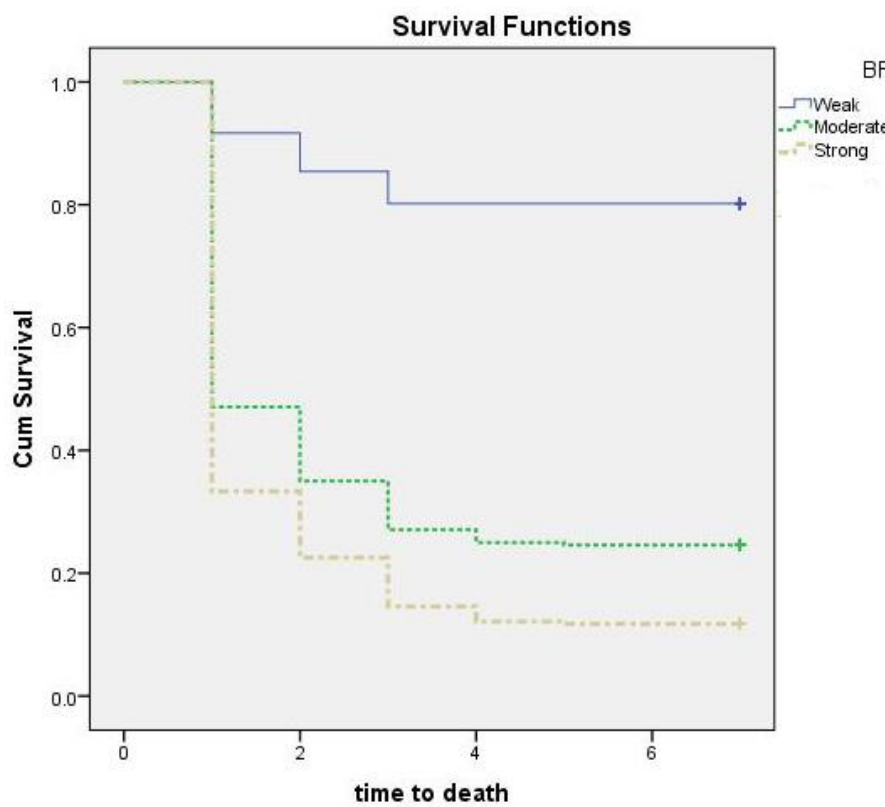
Figure 2. Pairwise comparison for the survival of G. mellonella larvae infected with clinical carbapenem-resistant Acinetobacter baumannii (CRAB); BF, biofilm. Isolates divided into three groups according to its biofilm-producing ability (poor (N = 6), moderate (N = 15), and strong (N = 33)). The larvae were injected with 10 5 colony-forming units (CFU) into their last right proleg. Each isolate was tested against a group of 20 larvae, which were kept for 7 days at 37 °C, and examined for death every 24 h. The experiments were performed three times, and the average reading was considered.